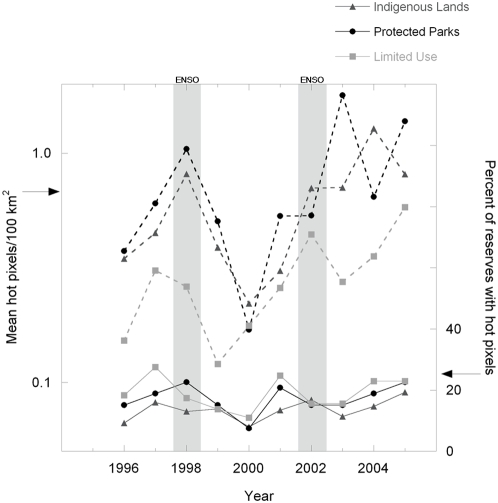
Differences in fire frequencies between fully protected parks, indigenous lands, and limited-use areas in the Brazilian Amazon.Solid lines (right axis) show the percentage of each reserve type (each year) with at least 1 hot pixel. Dashed lines (left axis) show the average number of hot pixels/100 km2 in those reserves that do have at least 1 hot pixel. Grey stripes indicate ENSO years.